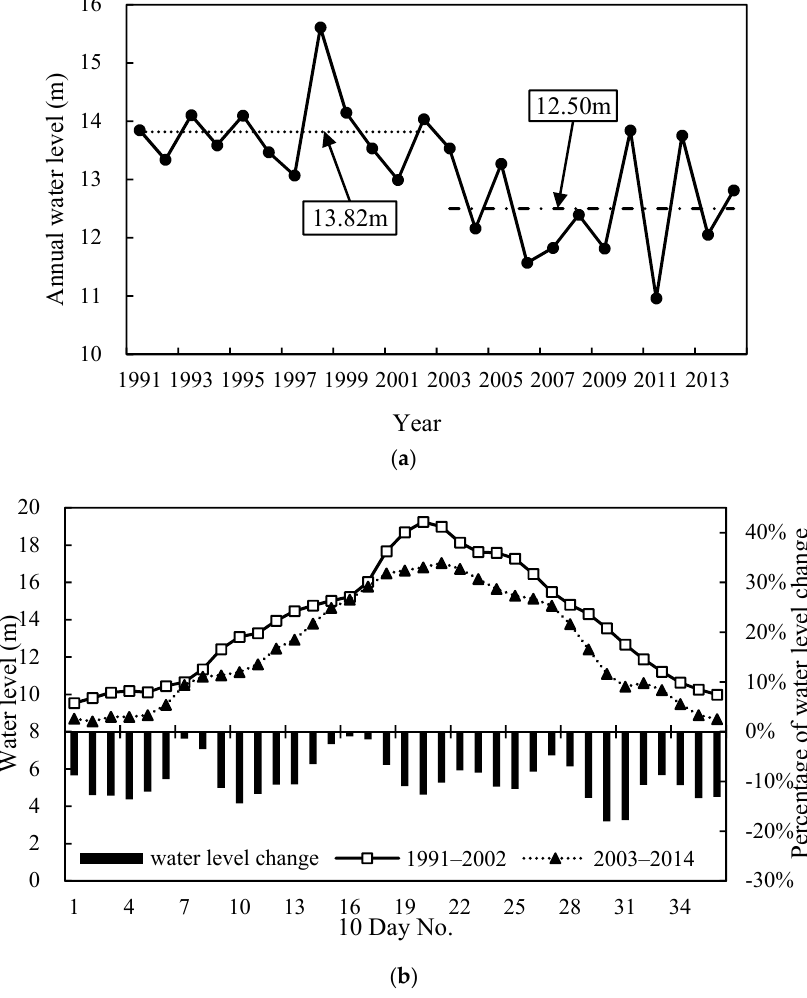
Figure 2. Water level at Xingzi Station: ( a ) annual water level from 1959 to 2014, ( b ) inner-annual 10 day mean water level during different periods.